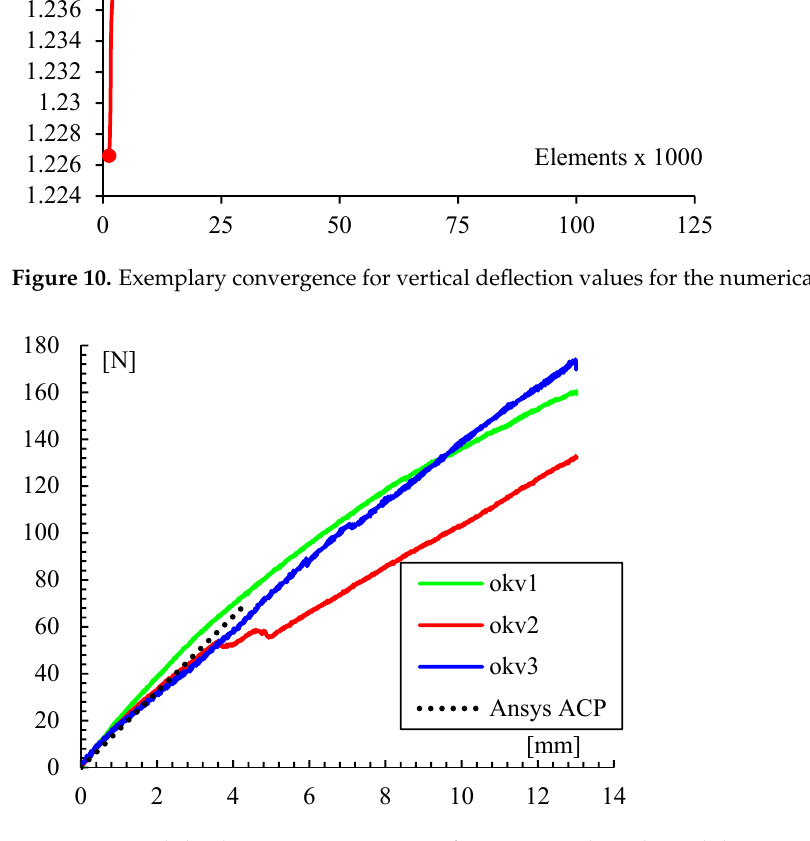
Figure 10. Exemplary convergence for vertical deflection values for the numerical simulation .